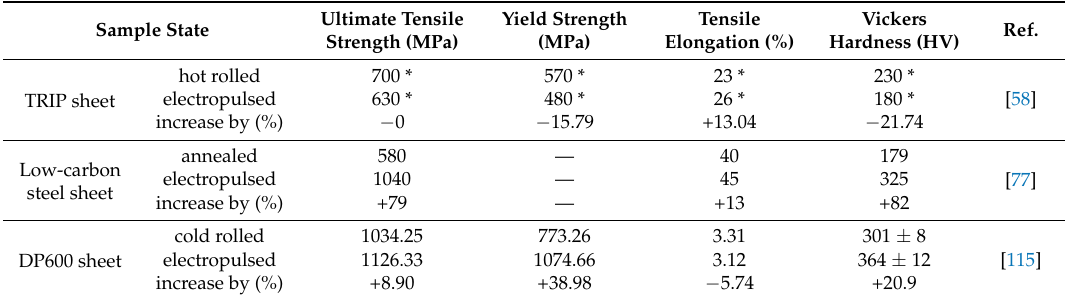
Table 4. Mechanical properties of steels before and after EPT. TRIP, transformation-induced plasticity.